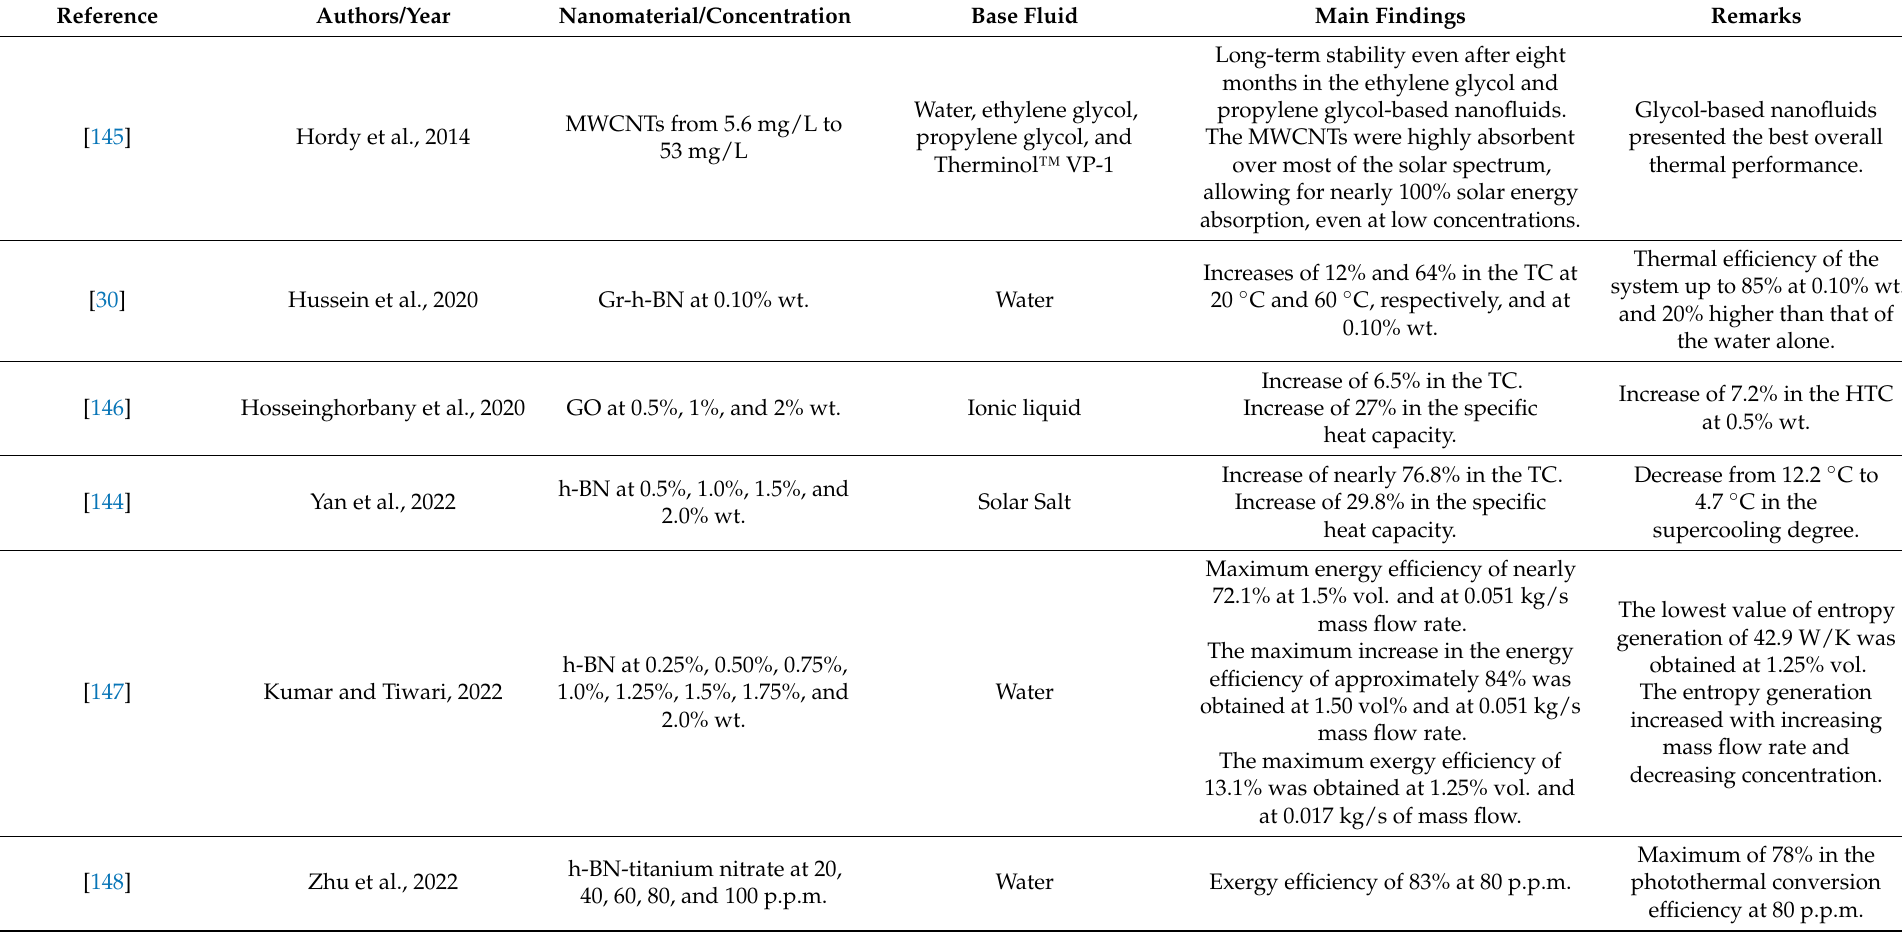
Table 9. Recent works on the use of 2D nanofluids and hybrids in the CSP field of